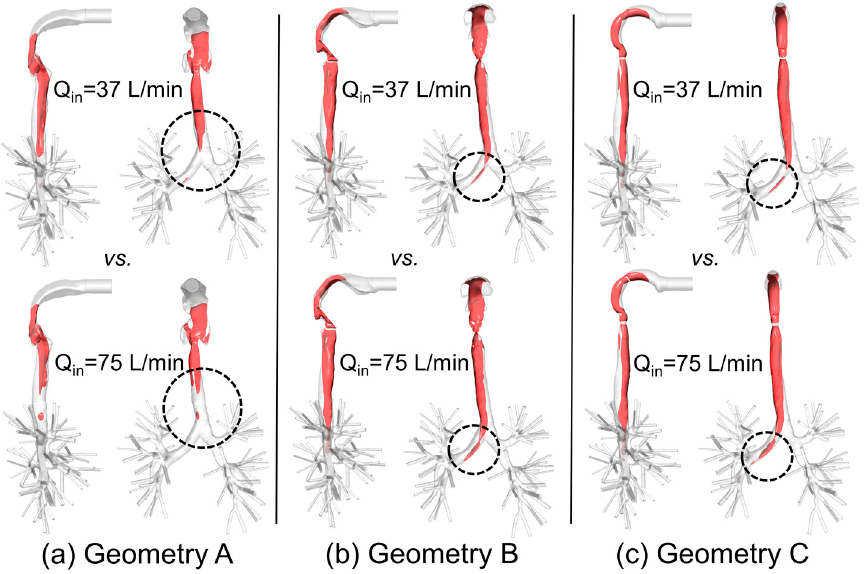
Figure 9. Iso-surfaces of the laryngeal cores (cid:1847)(cid:3553) = ‖(cid:1873)(cid:4652)(cid:1318)‖/(cid:1847) (cid:3036)(cid:3041) = 1.5 in three geometries under two steady-state inhalation flow rates (Q in = 37 L/min vs. Q in = 75 L/min): ( a ) Geometry A; ( b ) Geometry B; ( c ) Geometry C.